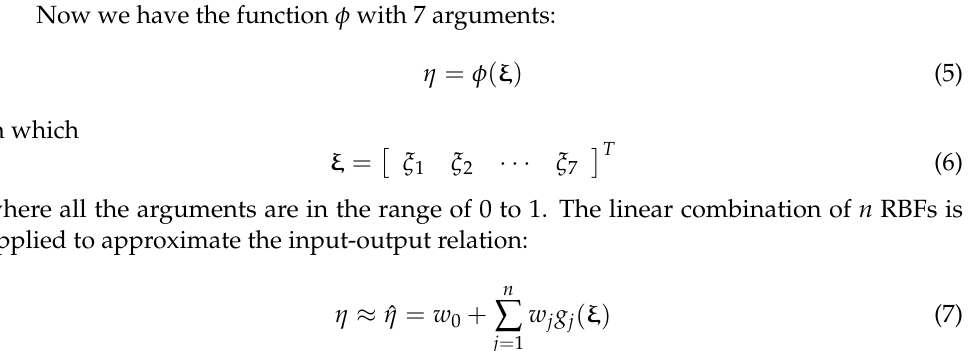
Table 1. The ranges of the inputs and the output of the raw data [26,27,35–39]. Factors Symbol Maximum Minimum Unit water x 1 295 116.5 kg/m 3 cement x 2 643 74 kg/m 3 fine aggregate (sand) x 3 1293 30 kg/m 3 Inputs coarse aggregate (gravel) x 4 1226 436 kg/m 3 blast furnace slag x 5 440 0 kg/m 3 fly ash x 6 330 0 kg/m 3 superplasticizer x 7 27.17 0 kg/m 3 Output 28-day compressive strength y 95.3 5